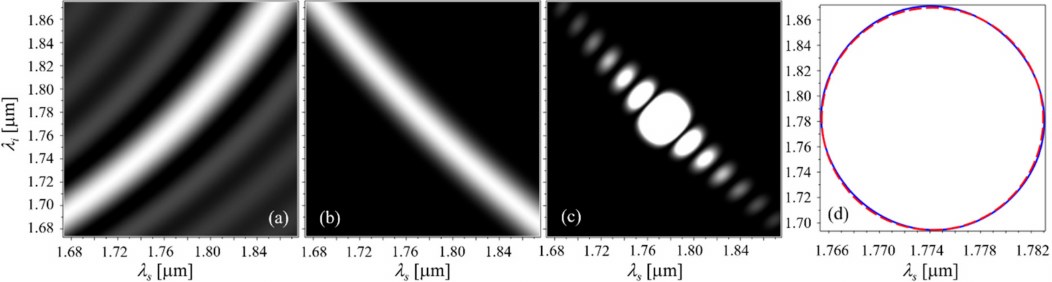
Figure 6. For Type II case (5) in Table 1: ( a ) PM function, ( b ) Pump envelop function, ( c ) JSI, and ( d ) the contour line for JSI = 0.5 (solid line) shown with a circle with a diameter of 27 nm (dashed line). The calculated purity is 0.997.